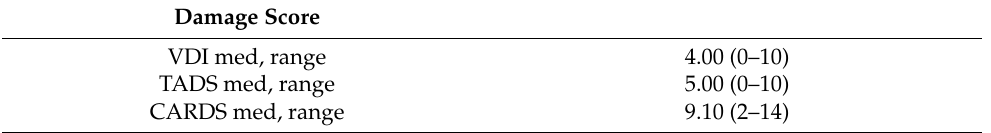
Table 3. Assessment of Damage in TA